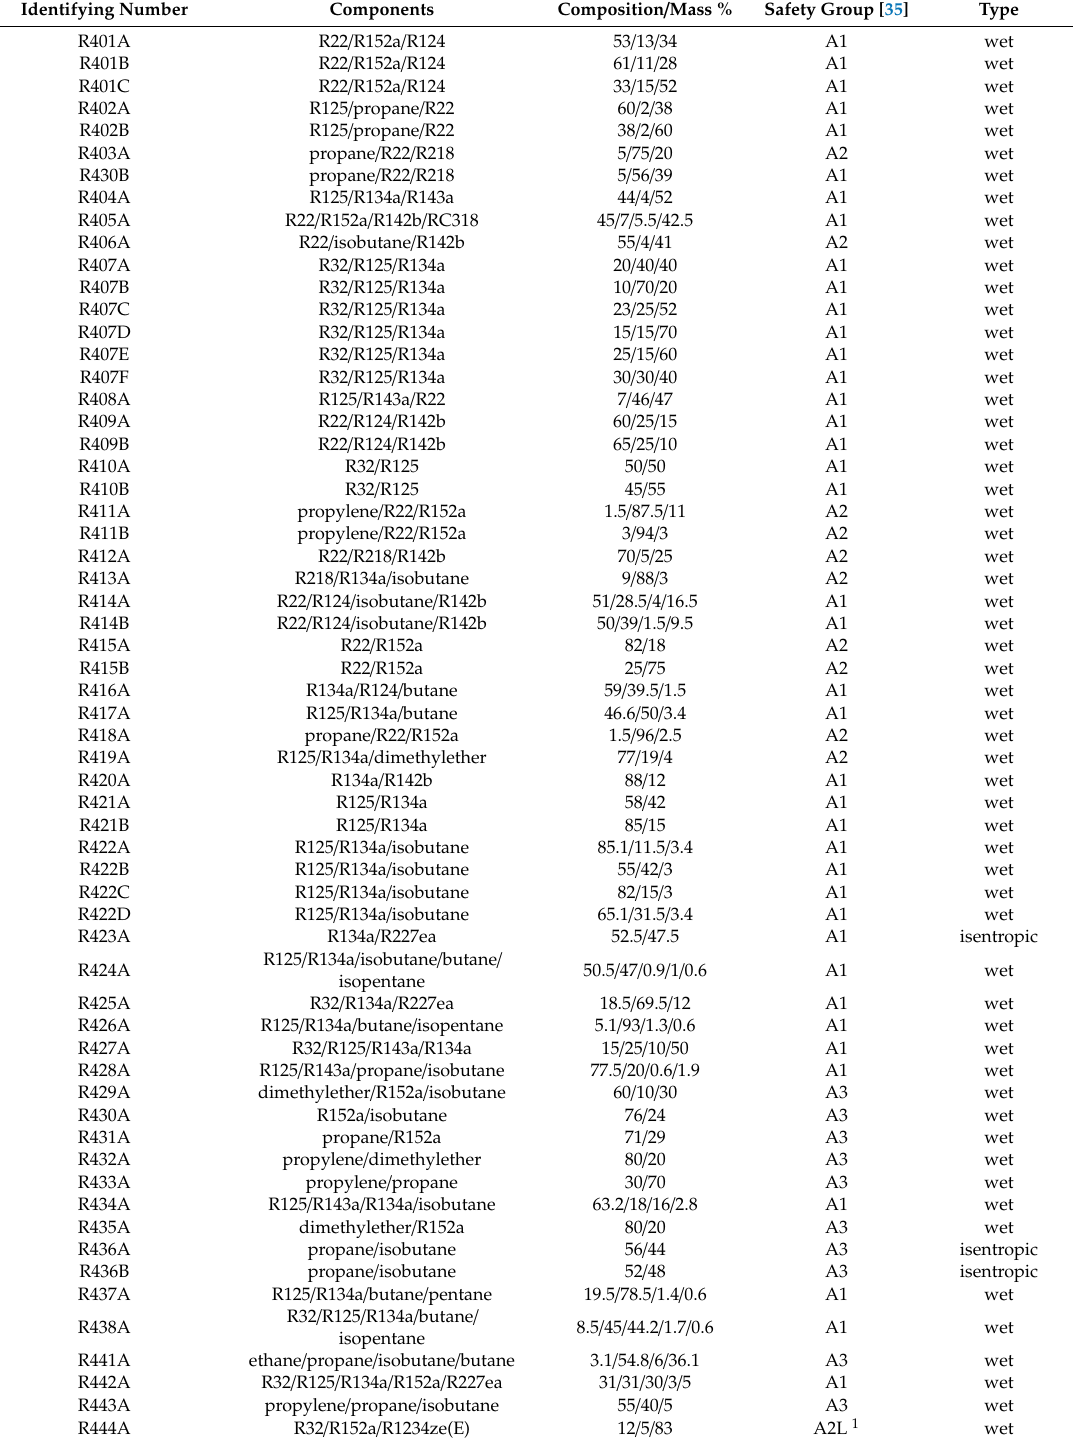
Table 2. Basic properties of the 61 zeotropic